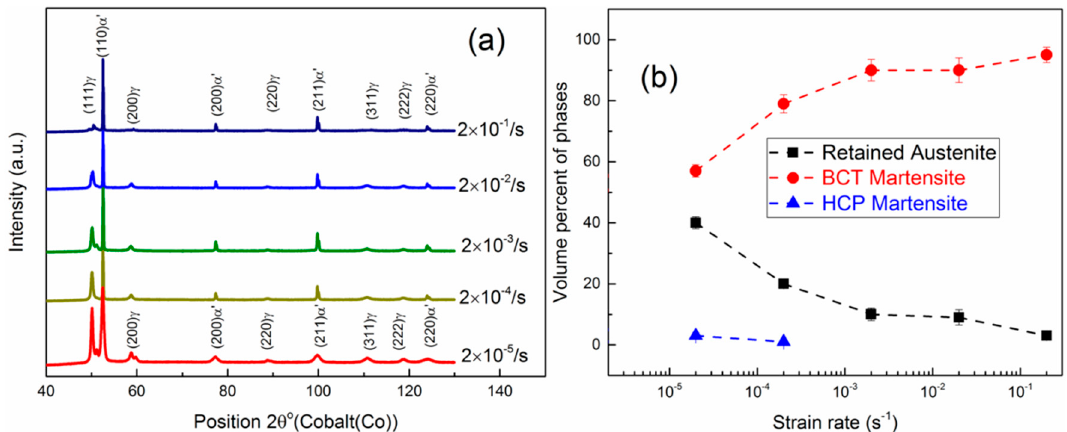
Figure 2. ( a ) X-ray diffraction of high carbon steel compressed at different strain rates at room temperature show the martensitic phase transformation of RA; ( b ) Deformation-induced samples show decreasing RA fraction and increasing martensite with increasing stress.